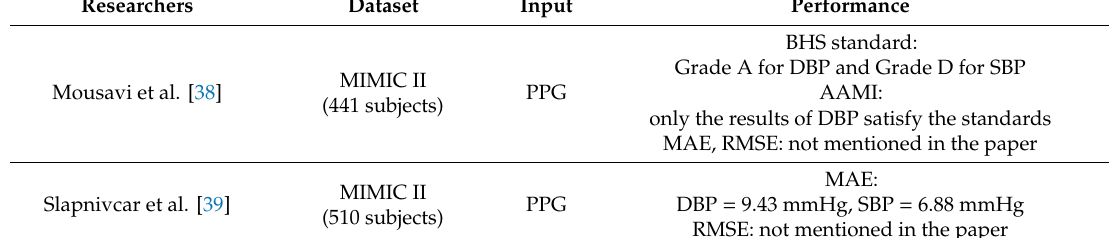
Table 3. Comparison of different models using PPG only as input for BP estimation.